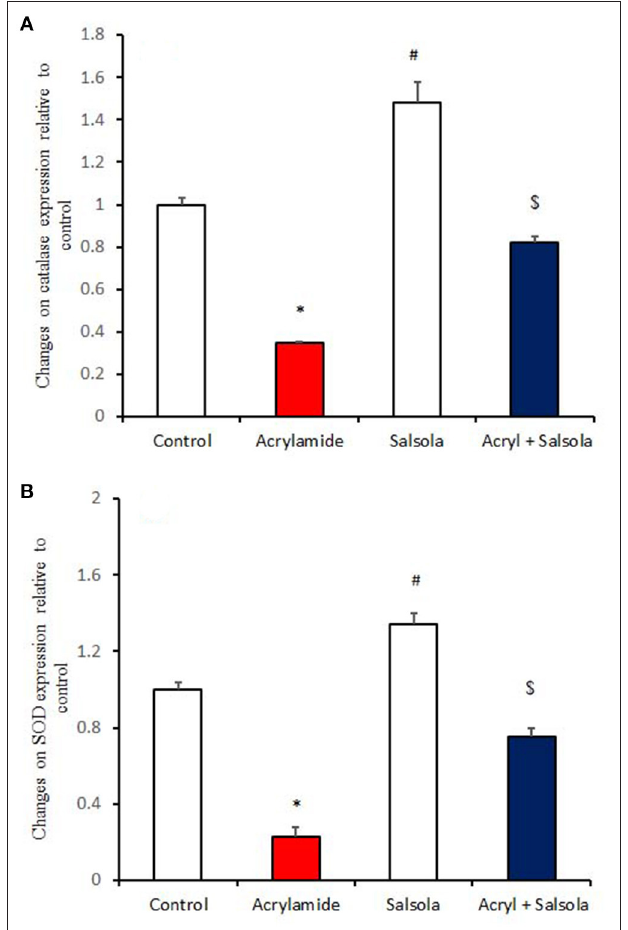
FIGURE 3 | The ameliorative impact of Salsola imbricata extract on the mRNA expression of catalase and SOD in acrylamide-administered rats. Graphic presentation of hepatic expression according to qRT-PCR analysis of catalase and SOD in different groups of rats after normalization with the housekeeping gene (actin). * p < 0.05 vs. the control group; # p < 0.05 vs. the other groups; $ p < 0.05 vs. the acrylamide-administered group.